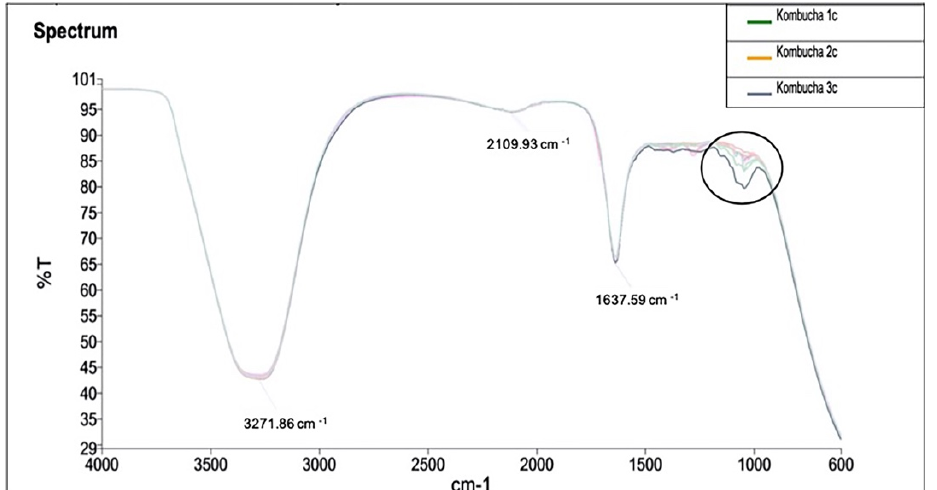
Figure 8 . FTIR analysis of kombucha samples to identify the vibrations and absorbance of chemical functional groups. The spectrum is recorded at wavelength range of 4000 to 600 cm -1 by measuring the infrared transmitted (%T). A differential peak is observed at wavelength between 1100 cm - 1 to 1000 cm -1 .